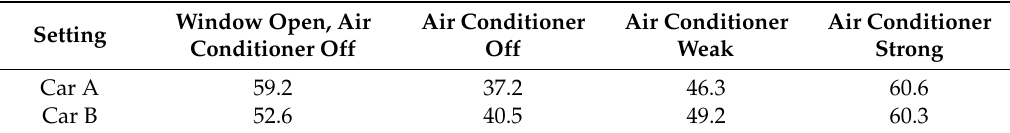
Table 1. Background noise level, L Aeq [dB], for each